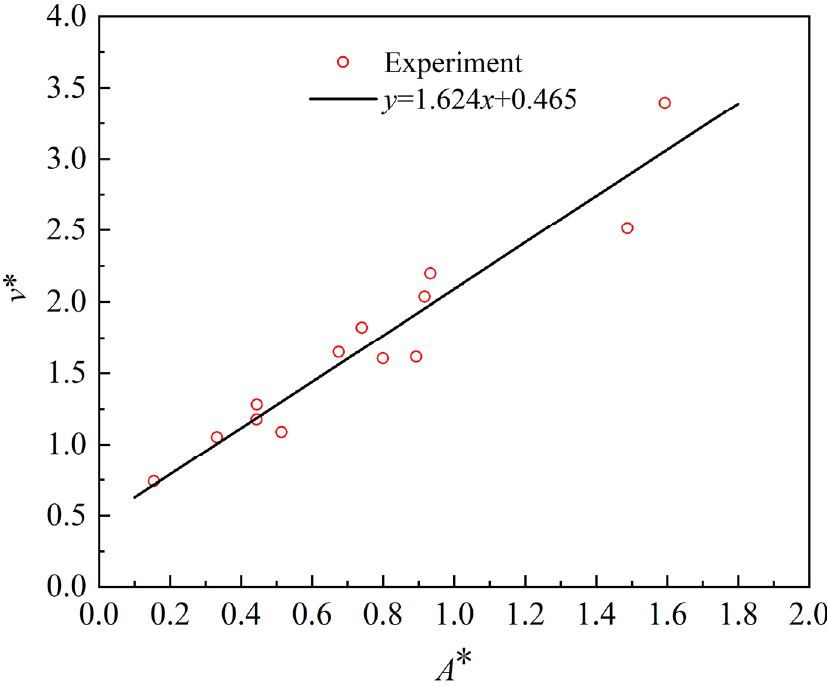
Figure 17. The dimensionless dynamic characteristic curve of the dual disc check valve.